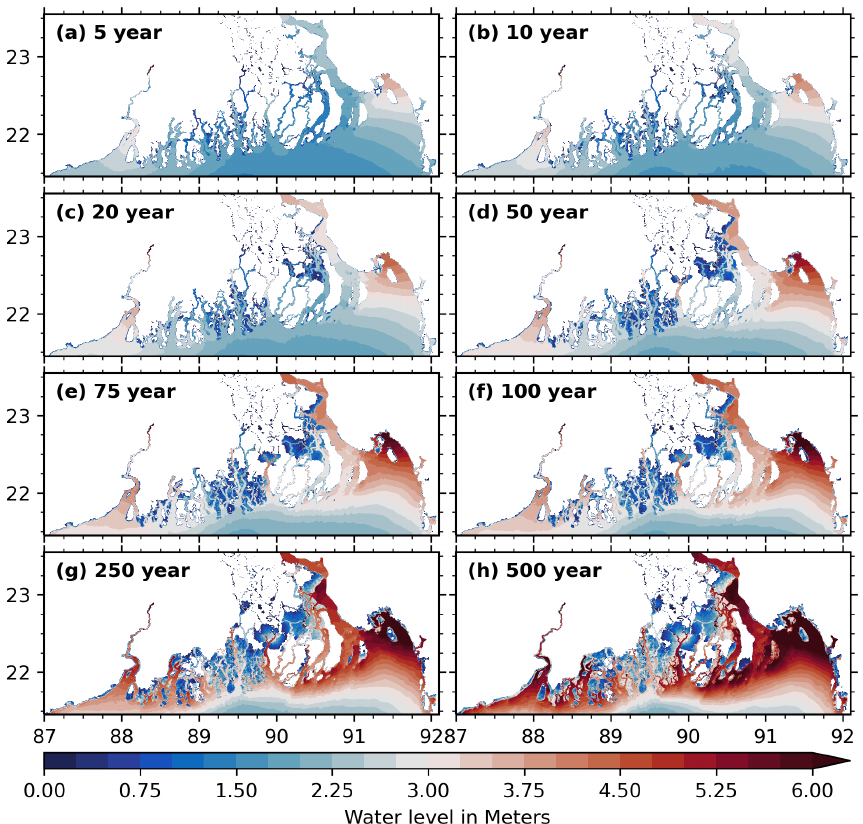
Figure 7. Inundation extent and corresponding water level at (a) 5-year, (b) 10-year, (c) 20-year, (d) 50-year, (e) 75-year, (f) 100-year, (g) 250-year, and (h) 500-year return